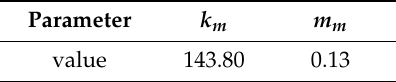
Table 2. Calibration results of Equation (5).